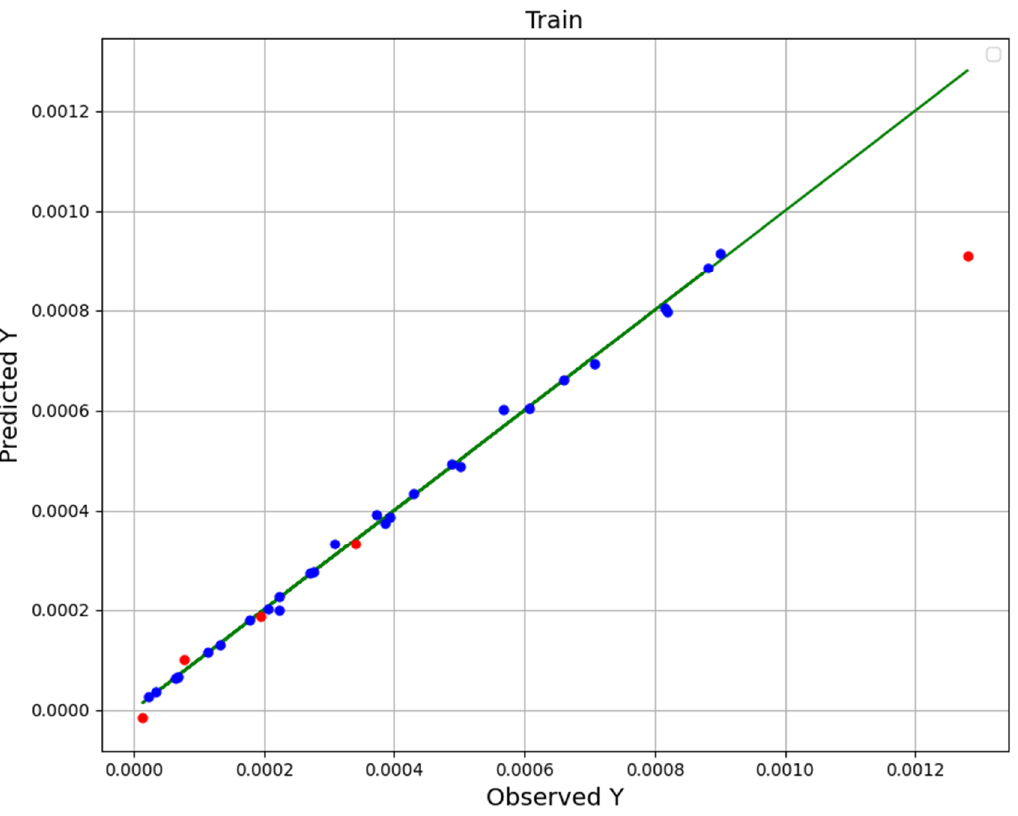
Figure 1. GPR fitting chart.